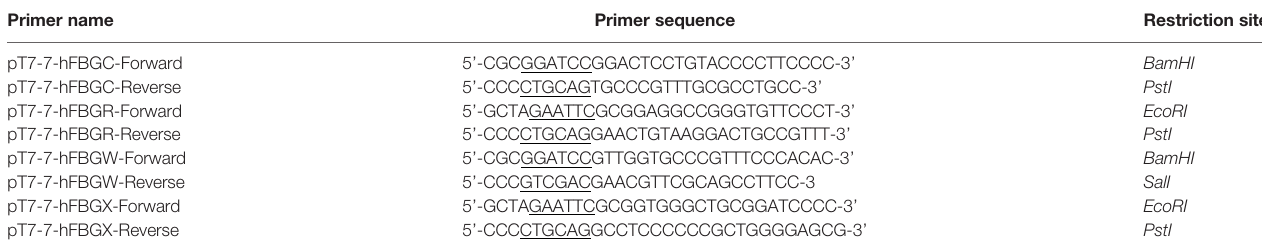
TABLE 2 | Oligonucleotide primers used for the cloning of the FBG-like domains in the pT7.7 vector using standard